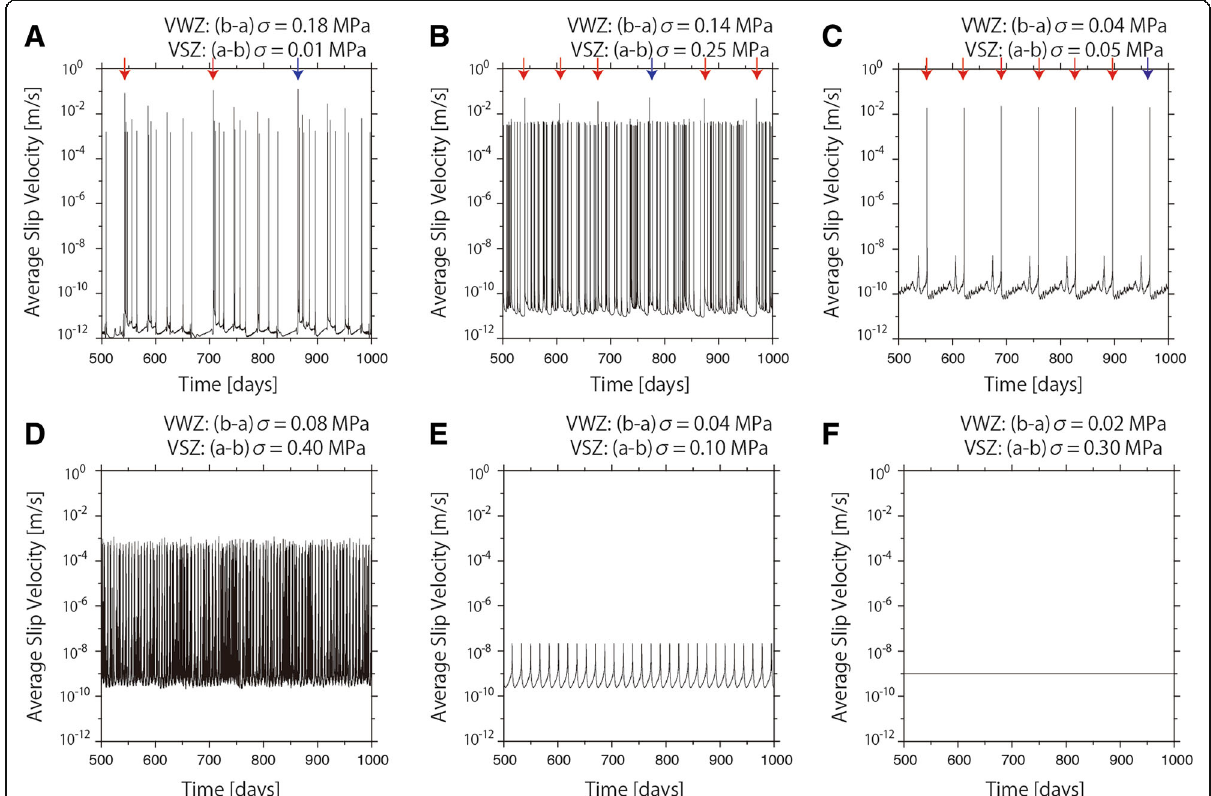
Fig. 2 Examples of simulation results. The slip velocity averaged in the seismogenic zone is shown for parameter sets A – F . Arrows in A – C represent the times of mainshocks. Detailed slip behavior of mainshocks denoted by blue arrows is shown in Fig.